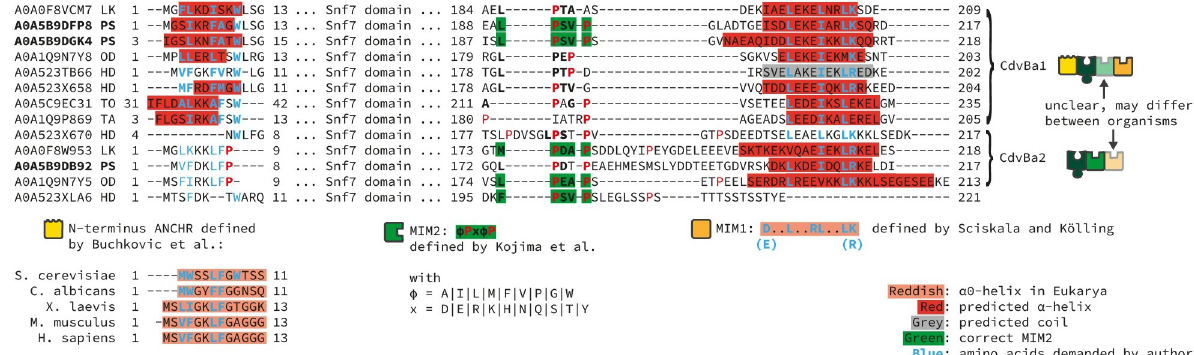
Fig 5. Multiple sequence alignment and potential domains of Asgard CdvB homologs. Predicted secondary structure is indicated by background colour, amino acids matching regular expressions of specific domains as defined in the literature are indicated by font colour. Prolines in red. Protein sequences of the different clades in the phylogeny ( Fig 3 ), CdvBa1 and CdvBa2, differ mostly at the N-terminus, where in all but one sequences of CdvBa1 an alpha helix is predicted, whilst in in all CdvBa2 proteins no alpha helix is predicted. Abbreviations: LK: Lokiarchaeum sp. GC14_75, PS: Candidatus P. syntrophicum MK-D1, OD: Candidatus Odinarchaeota archaeon LCB_4, HD: Candidatus Heimdallarchaeota archaeon, TO: Candidatus Thorarchaeota archaeon (strain OWC), TA: Candidatus Thorarchaeota archaeon strain